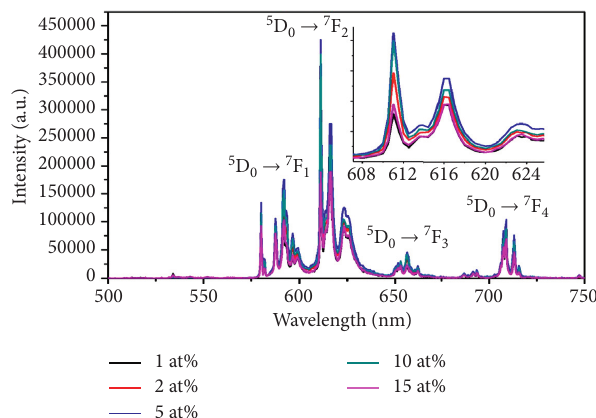
Figure 4: The emission spectra of SrGd different doping concentrations.